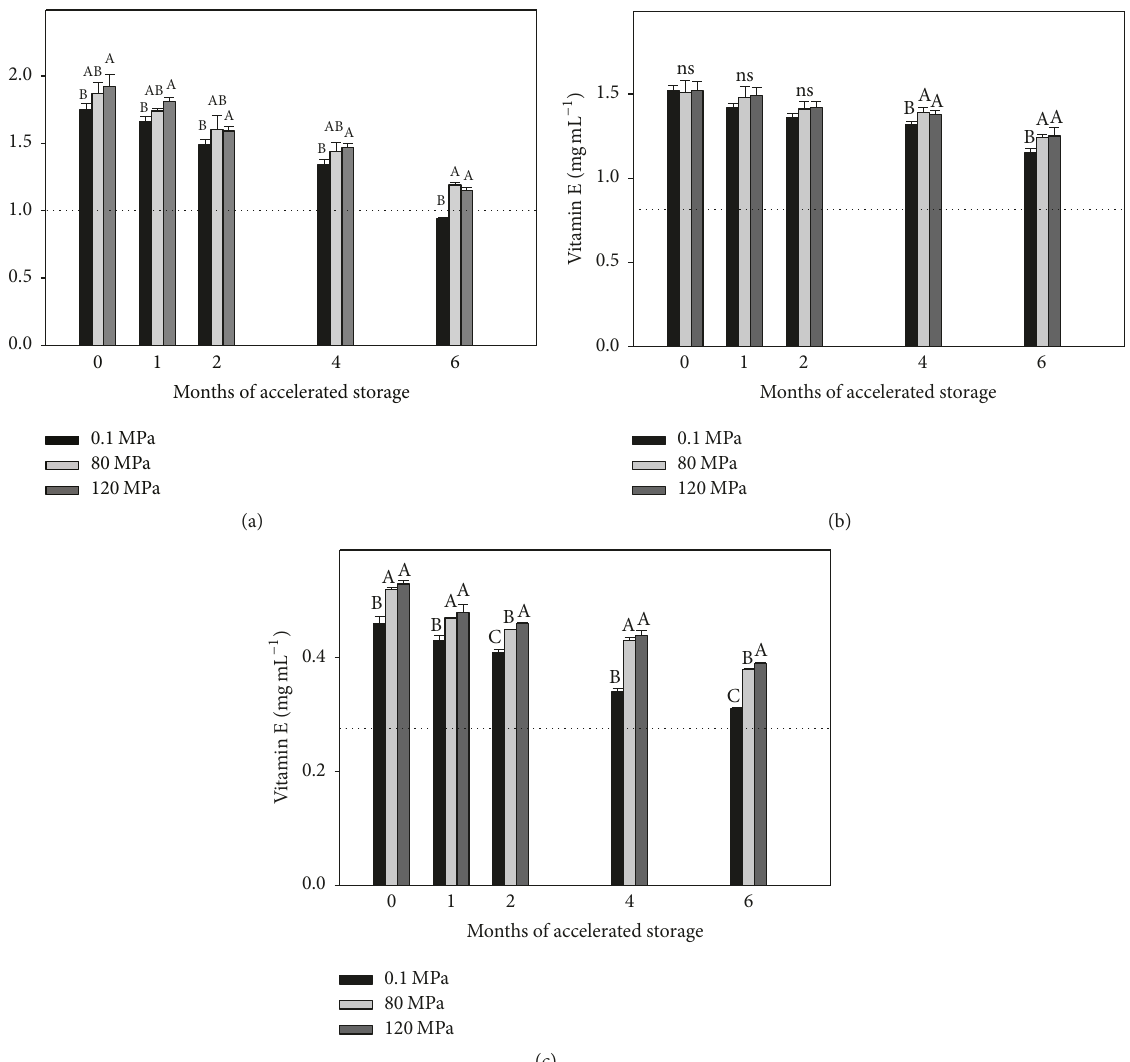
Figure 4: Effect of HPH treatments on the total vitamin E content of artichoke (a), royal jelly (b), and iron food supplements (c) stored at 40 ∘ C ± 2 ∘ C and 75% ± 5% RH. Mean ( 𝑛 = 3 ± SD). Different letters within the same day indicate significant differences between pasteuri- zation and HPH treatments at 𝑝 ≤ 0.05 . ns: not significant. The dotted line indicates 50% vitamin losses with respect to the initial contents shown in Table